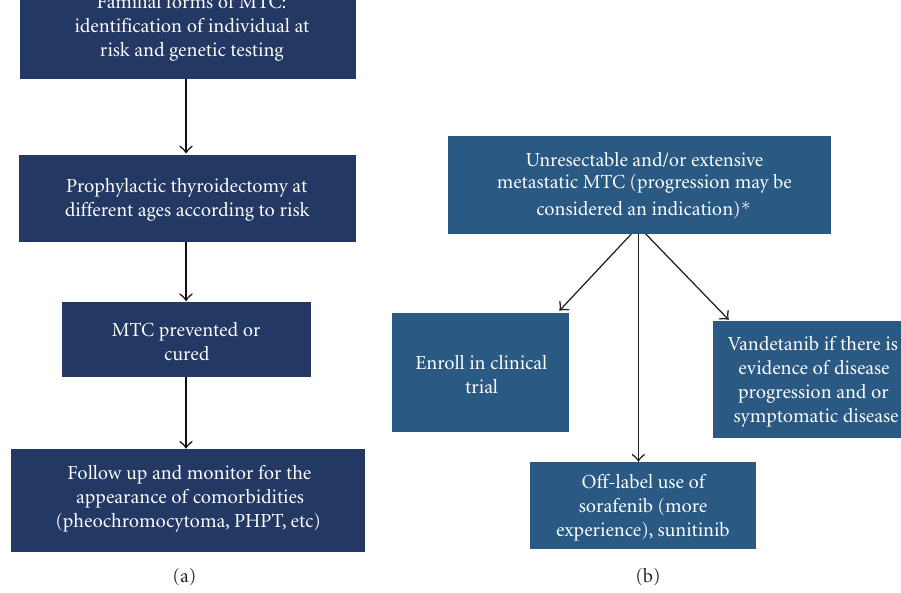
Figure 1: From prevention of MTC to treatment of incurable disease. Ideal approach to familial forms of MTC (a) versus treatment options in unresectable and/or extensive metastatic disease and/or progression. (b) ∗ Every patient should be evaluated in an individual basis, and the decision to treat as well as the indication is not always clear cut as one must take into consideration quality of life issues and adverse events associated with